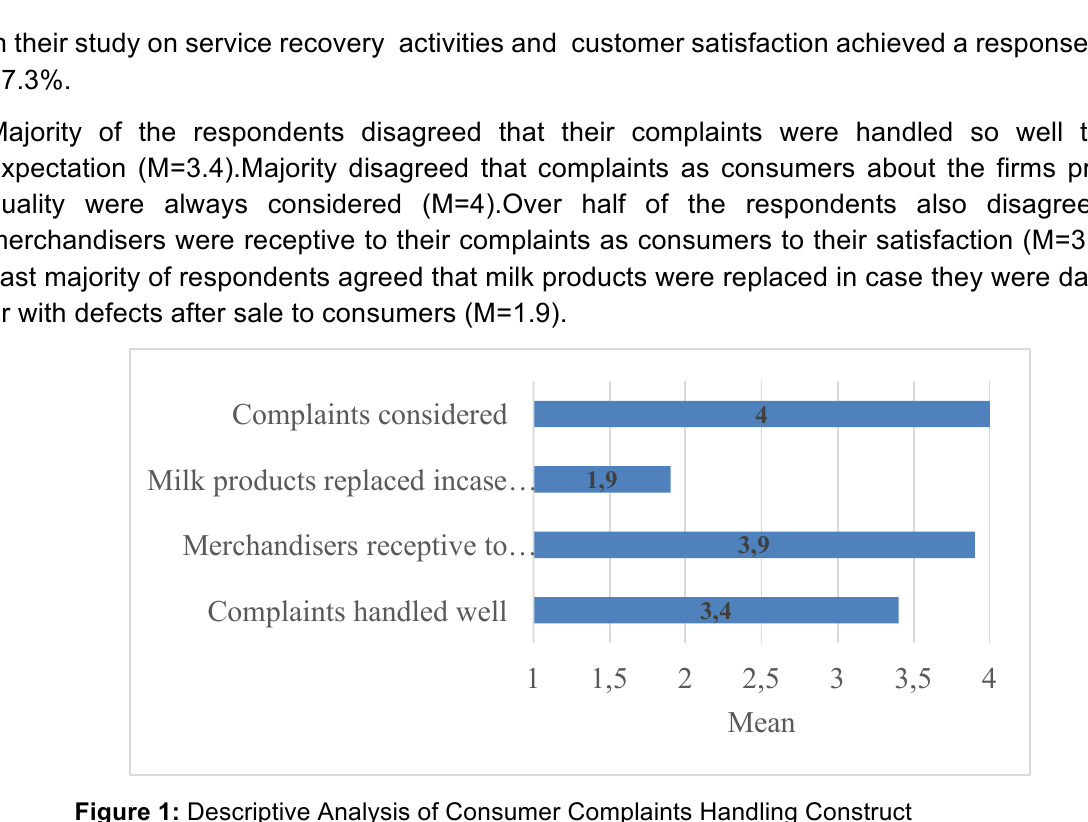
Figure 1: Descriptive Analysis of Consumer Complaints Handling Construct The vast majority indicated that they were satisfied with their preferred milk processors products (M=1.46).The vast majority of respondents indicated that they were satisfied with the quality of their preferred milk products (M=1.42).Similarly, majority indicated that they spread a positive word of mouth about preferred milk processors products